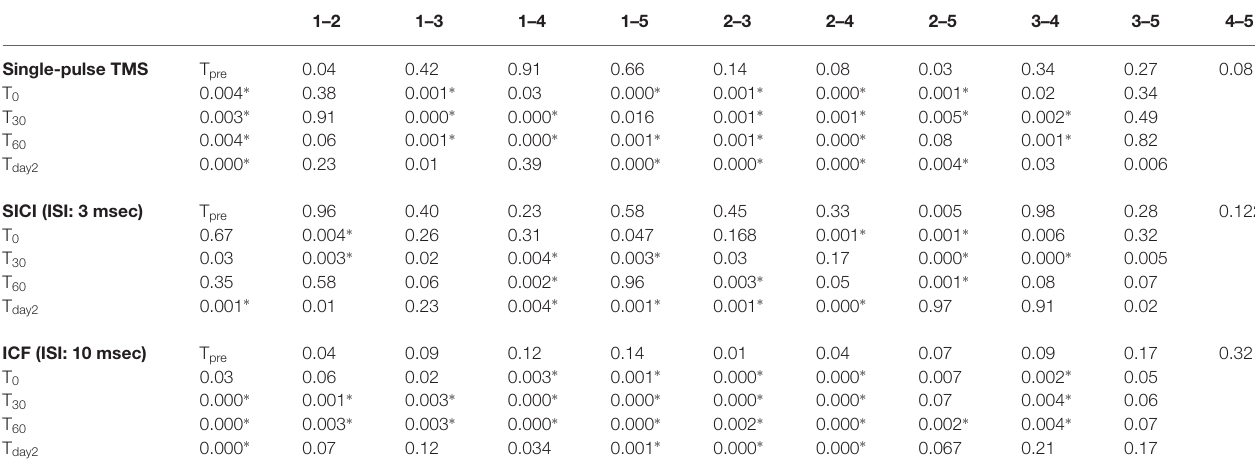
TABLE 1 | Summary of post hoc comparisons of means differences at each time-point of measurement for the effects of conventional a-tDCS of M1 and unihemispheric concurrent dual-site a-tDCS on M1 corticospinal excitability dual a-tDCS stimulations on CSE of M1.